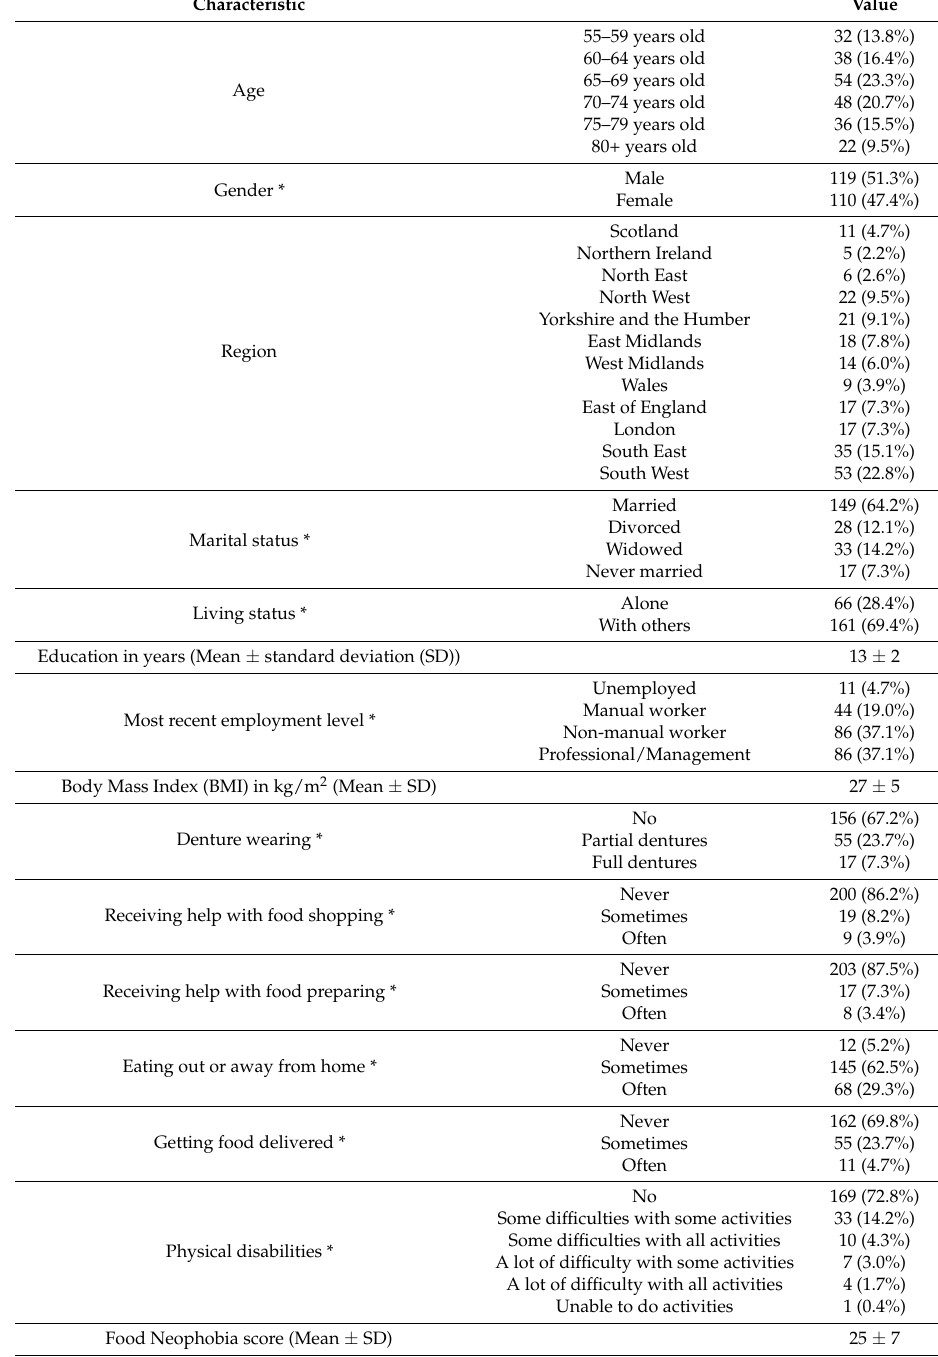
Table 1. Participant characteristics ( n =